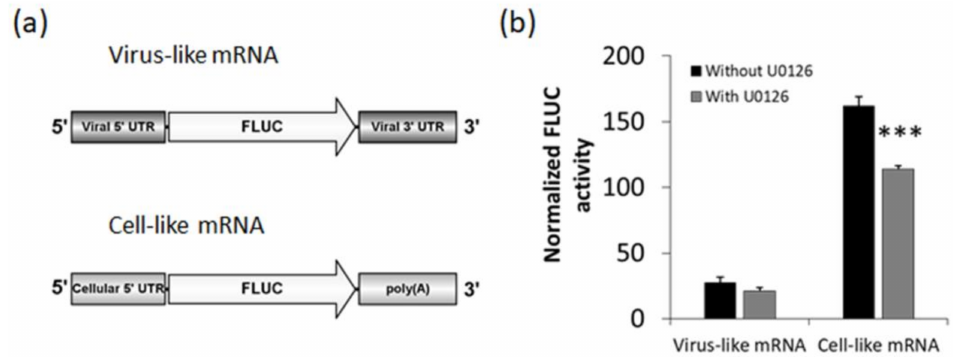
Figure 5. U0126 does not affect viral mRNA translation. ( a ) Schematic representation of capped synthetic transcripts used in this study; ( b ) BSR cells were transfected with virus- or cell-like mRNA, along with a transcript (RLUC), expressing RLUC in a cap-independent manner, as an internal control (Materials and methods). Three h post-transfection, cells were treated or not with U0126 for 4 h, followed by the determination of FLUC and RLUC activities in cell lysates. Mean normalized FLUC values (FLUC/RLUC ± SD) from two independent experiments (each performed in triplicate) are shown. ANOVA (Tukey post-hoc test): *** p <